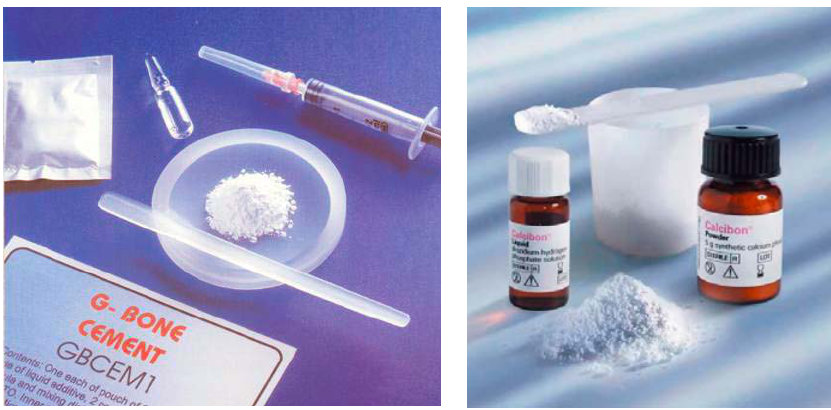
1. A presentation of two randomly